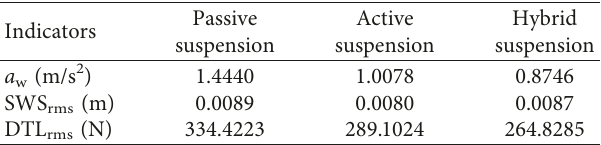
Table 3: The dynamic response root mean square values of the hybrid suspension in urban circulation unit.